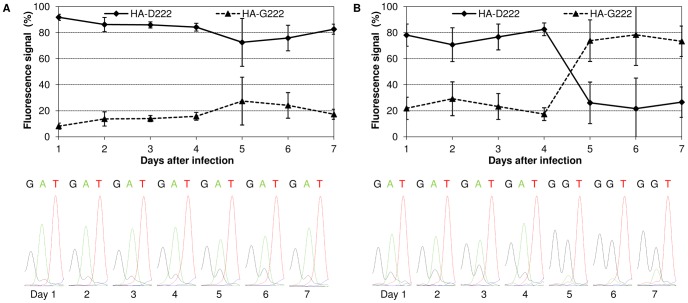
Proportion of HA-D222 and HA-G222 variant in lung and trachea during infection.The percentage of the fluorescence signal for the HA-D222 and HA-G222 variant in the sequence chromatogram of (A) lung (day 1–5: n = 5; day 6–7: n = 10) and (B) trachea (day 1–4: n = 5; day 5: n = 4; day 6–7: n = 9) samples was analyzed from day 1 to 7 p.i. The signal for different variants was measured for all mice individually. Mean values and standard deviations displayed in the figures were calculated from mice that were dissected on the same day. For each day a representative chromatogram of a trachea and a lung sample is shown. The nucleotides GAT code for the amino acid aspartic acid (D) and GGT for glycine (G).